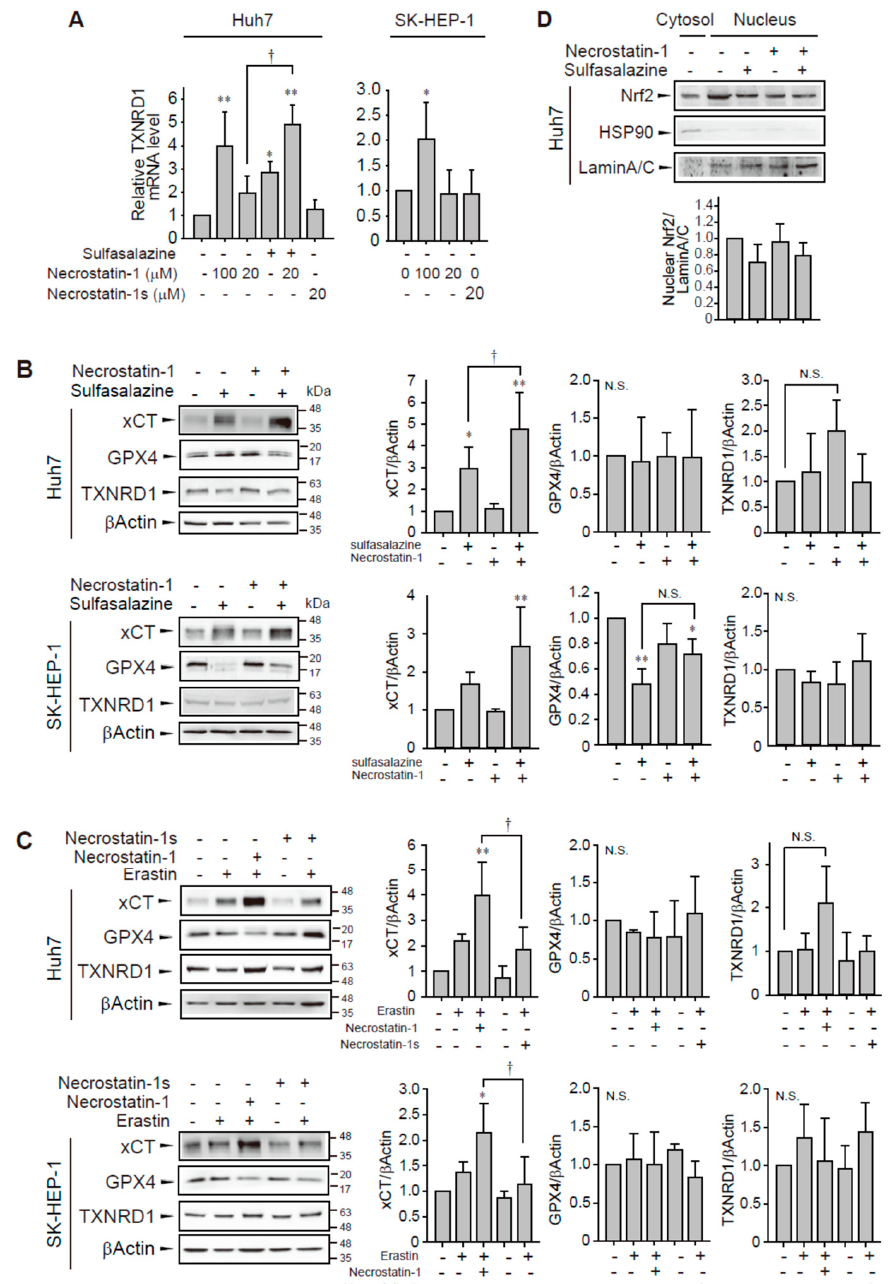
Figure 6. Effect of necrostatin-1 on xCT, GPX4, and TXNRD1 expression. ( A ) Huh7 cells were treated with vehicle, 20 μ M or 100 μ M necrostatin-1 or 20 μ M necrostatin-1s for 1 h, followed by 500 μ M sulfasalazine for 24 h. SK-HEP-1 cells were incubated with necrostatin-1 or necrostatin-1s for 24 h. Cells were lysed and subjected to real-time qPCR. Western blot analysis was performed with the cells which were pre-treated with 20 μ M necrostatin-1 or 20 μ M necrostatin-1s for 1 h and subsequently exposed to 500 μ M sulfasalazine ( B ) or 3 μ M erastin ( C ) for 24 h. ( D ) Cells were exposed to 500 μ M sulfasalazine for 18 h after pre-treatment of 20 μ M necrostatin-1 and fractionated as cytosol and nucleus. Heat shock protein 90 (HSP90) and lamin A/C were detected as a cytosolic and nuclear marker, respectively. Relative expression was calculated in comparison with vehicle group. Each experiment was repeated 3 times and data are expressed as means ± SDs. * p < 0.05, ** p < 0.01, vehicle versus treatment; † p < 0.05, necrostatin-1 versus sulfasalazine with necrostatin-1; N.S., not significant.